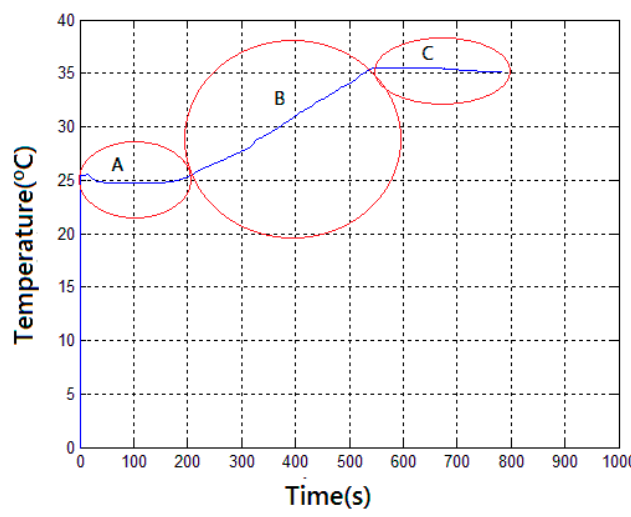
Figure 14. Wireless communication test. A: 50 V in the stator windings; B: 220 V in the stator windings; C: 100 V in the stator windings.